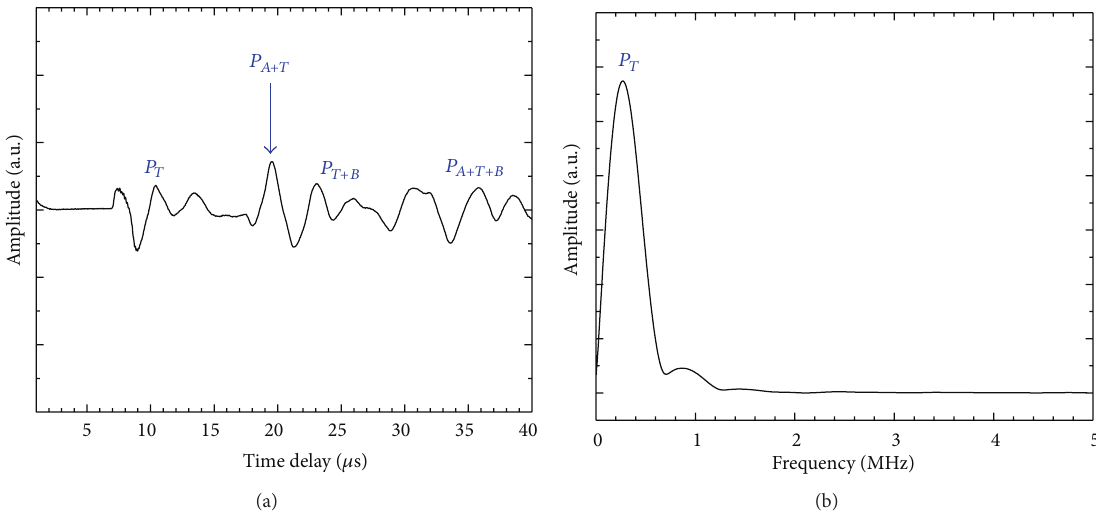
Figure 11: Ultrasonic performance of the IUTs shown in Figure 10 and operated in transmission mode. A 10-groove grating area was covered by the silver top electrode. (a) Signal in time domain and (b) spectrum of echo signal 𝑃 𝑇 .